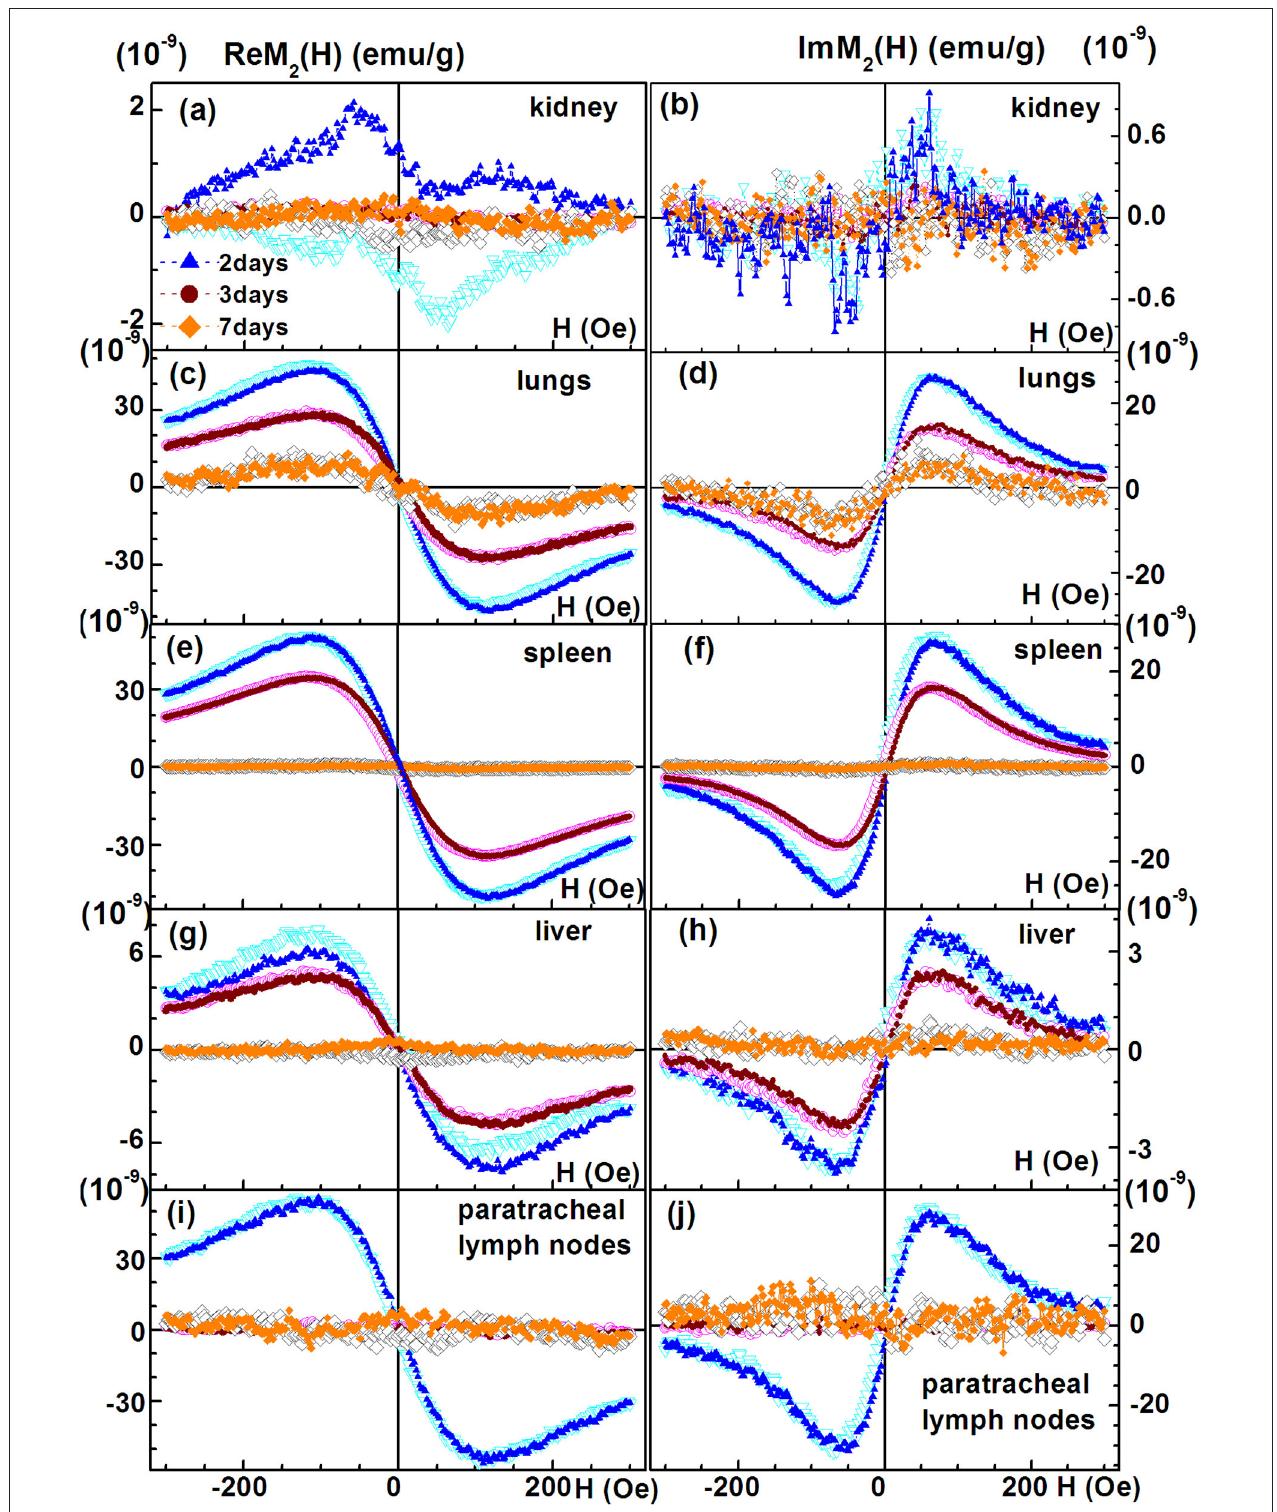
FIGURE 8 | Real and imaginary parts of the non-linear magnetic response as functions of the dc magnetic field direct (filled symbols) and reverse (open symbols) scans with F sc 8Hz for kidney, (A,B) ; lungs, (C,D) ; spleen, (E,F) ; liver, (G,H) ; and paratracheal lymph nodes, (I,J) at different time points following injection of = SPION-labeled MSCs. Except of kidney other organs’ probes reveal SPION-like M 2